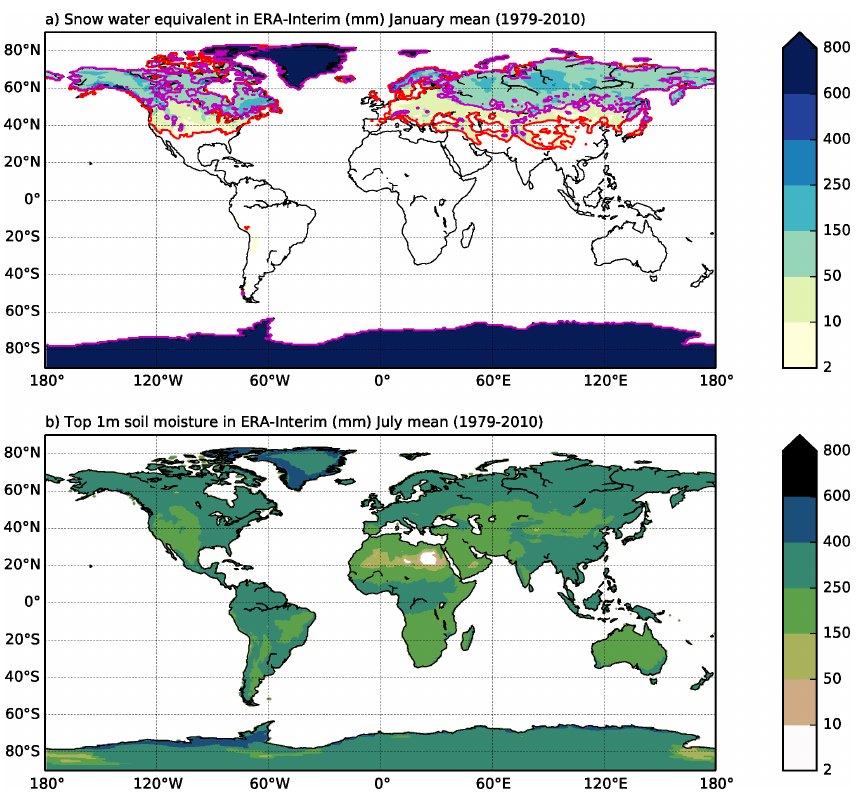
Figure 2. Median of the land water reservoirs in the 1979–2010 period for ERA-Interim: (a) snow water equivalent (SWE, kgm − 2 ) for the 10–20 January period, and (b) top 1m soil moisture (TCSM, kgm − 2 ) for the 10–20 July period. The red and magenta contours in (a) indicate the 5th and 95th percentiles, respectively, of 10kgm − 2 snow water equivalent as an indication of the year to year variability of snow